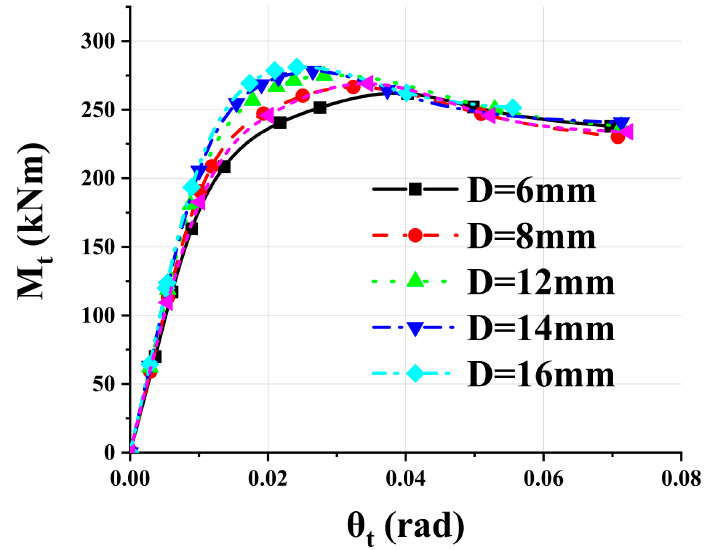
Figure 13. Moment-rotation curves of connections with different end plate thickness.